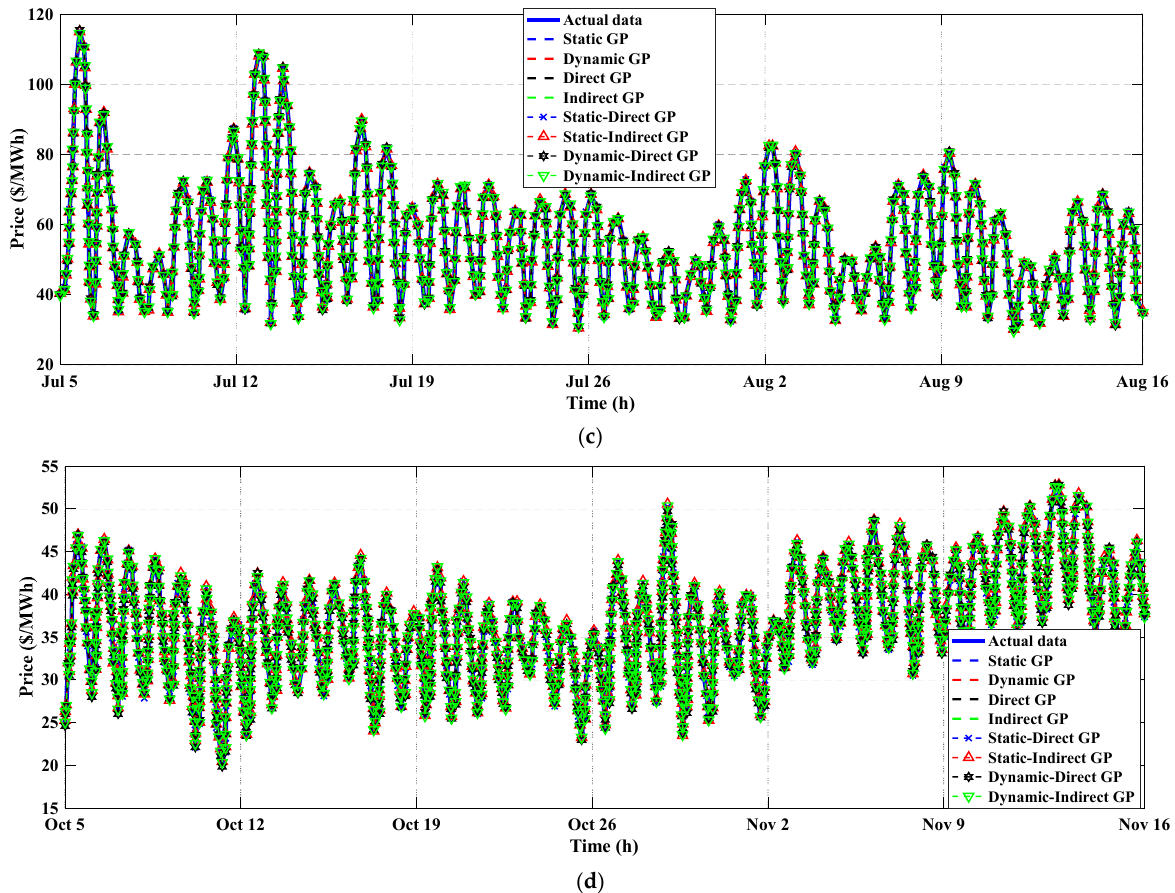
Figure 7. The forecasting of the main component of training data of EP using various models for the electricity market of the US: ( a ) winter, ( b ) spring, ( c ) summer, ( d ) autumn.